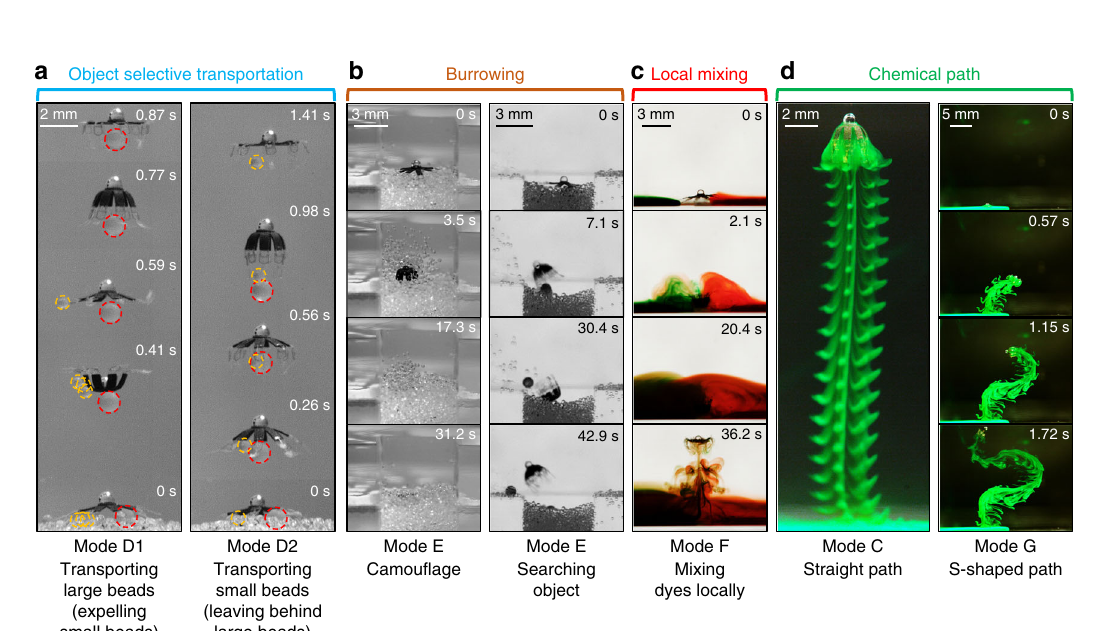
Fig. 7 Four tasks realized by newly prescribed modes extended from the fi ve basic modes. a Object selective transportation. The robot can use Mode D1 to transport large beads (diameter: 0.99 mm ± 0.025 mm, density: 1.05 g ⋅ cc -1 ) while expelling small beads (diameter: 500 – 600 µ m, density: 1.05 g ⋅ cc -1 ). It can also use Mode D2 to transport small beads and leave behind large beads. b Burrowing for camou fl age and searching in fi ne beads